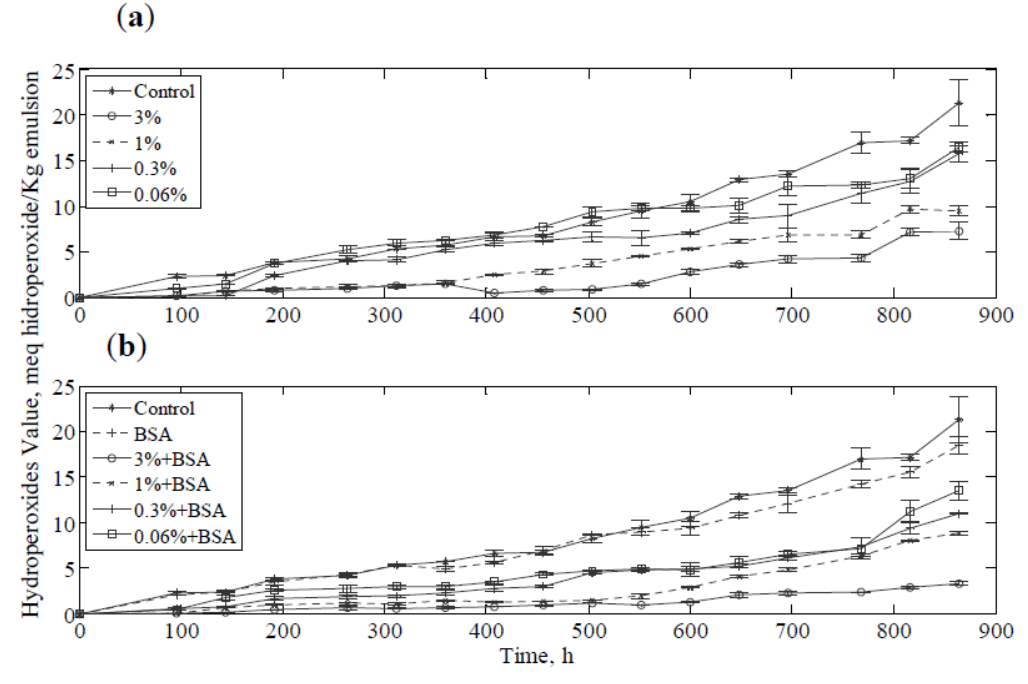
Figure 3. The peroxide values for the emulsions: ( a ) Samples with extract; ( b ) Samples with extract and 0.2%